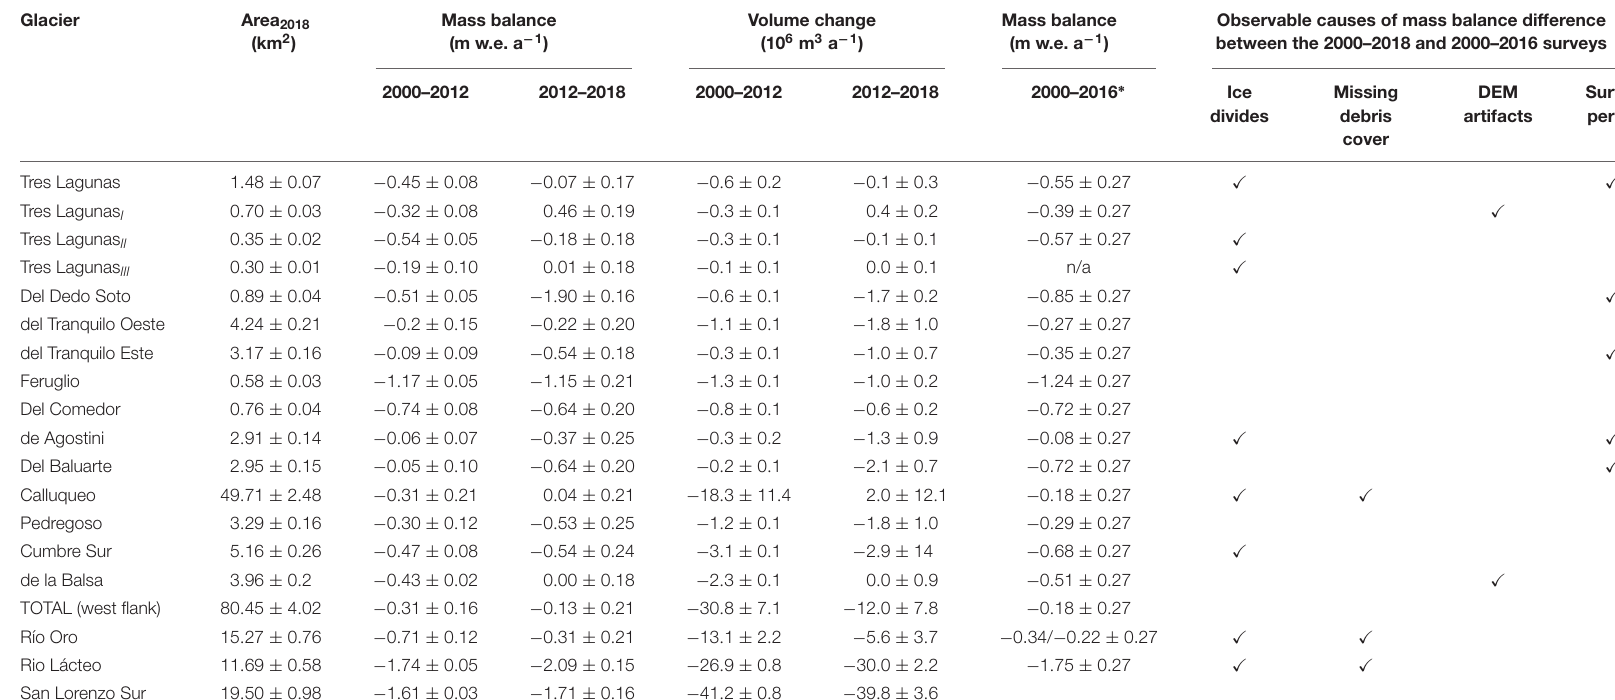
TABLE 3 | Mass budget comparison of 15 land-terminating glaciers in the western side of the main ridge and the three valley glaciers in the east flank of Monte San Lorenzo.